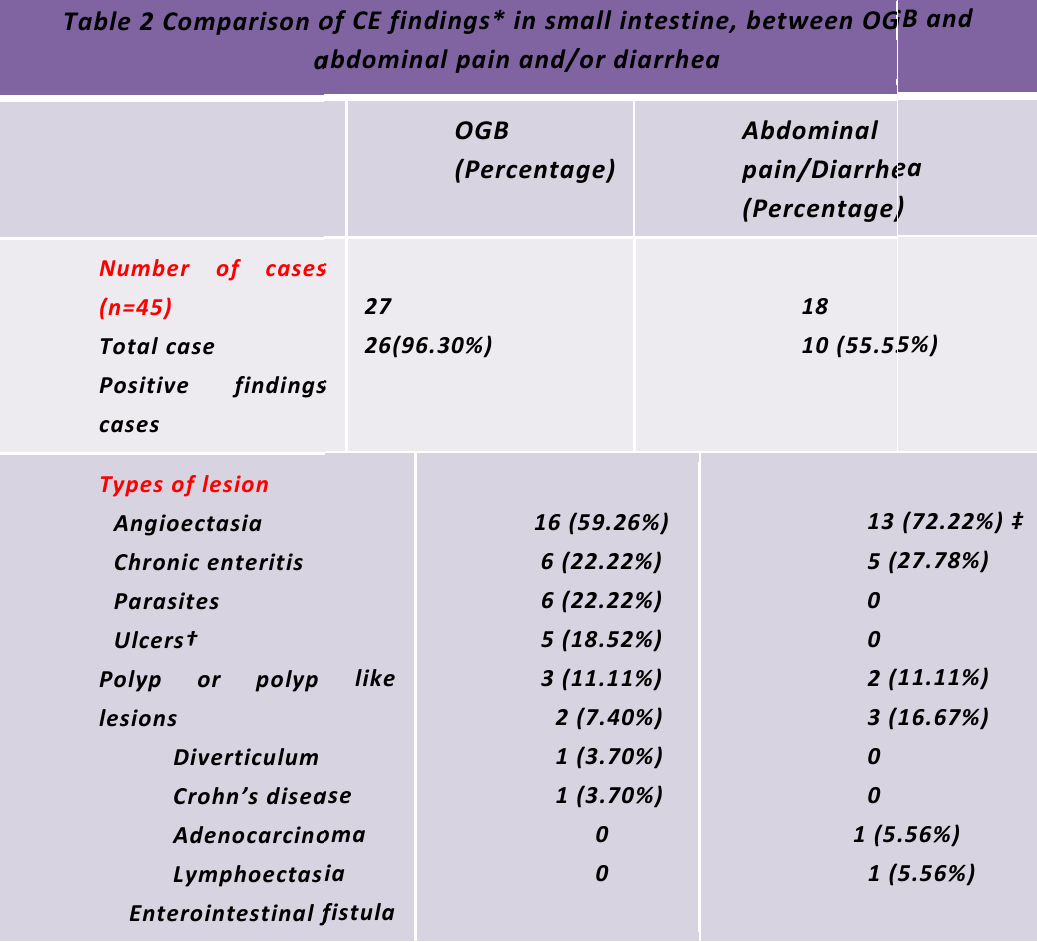
Table 2 Comparison of CE findings* in small intestine, between OGB